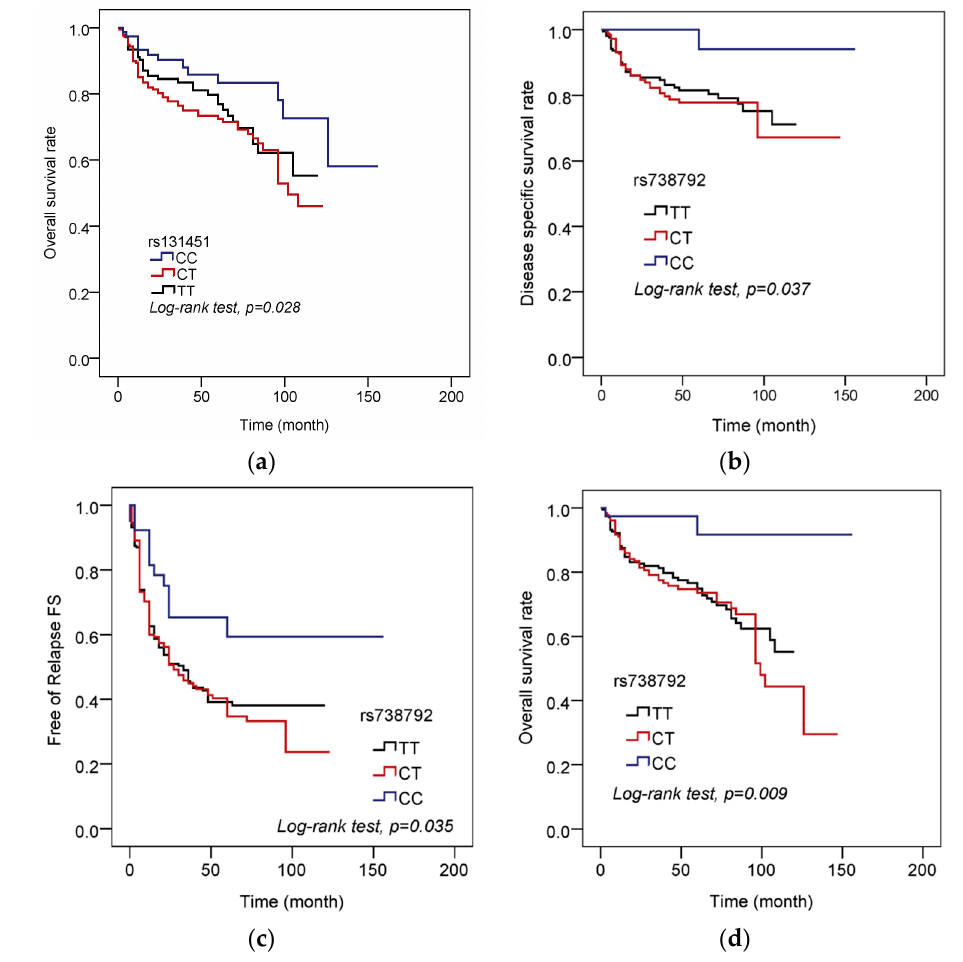
Figure 1. Distribution frequency of the overall survival rate, free of relapse and MMP11 polymorphism in 431 UCC patients. ( a ) Overall survival rate and MMP11 rs131451 genotype frequencies. ( b ) Disease specific survival rate and MMP11 rs738792 genotype frequencies. ( c ) Free of relapse (RS) and MMP11 rs738792 genotype frequencies. ( d ) Overall survival rate and MMP11 rs738792 genotype frequencies.